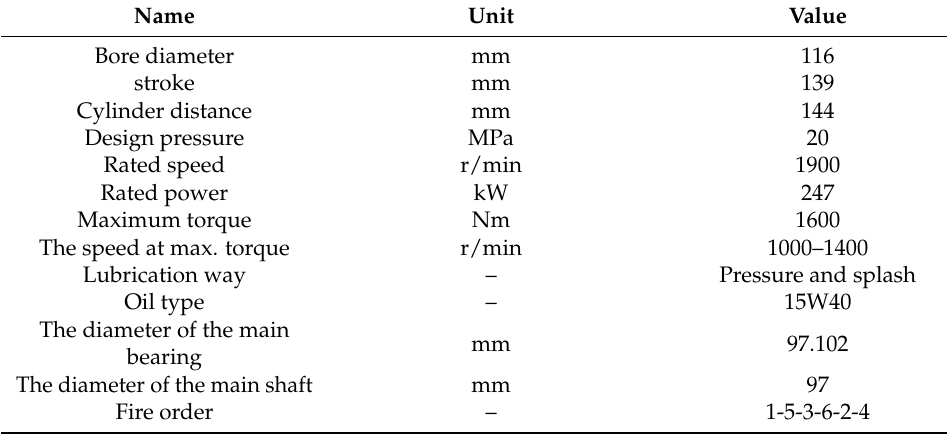
Table 1. Engine characteristic